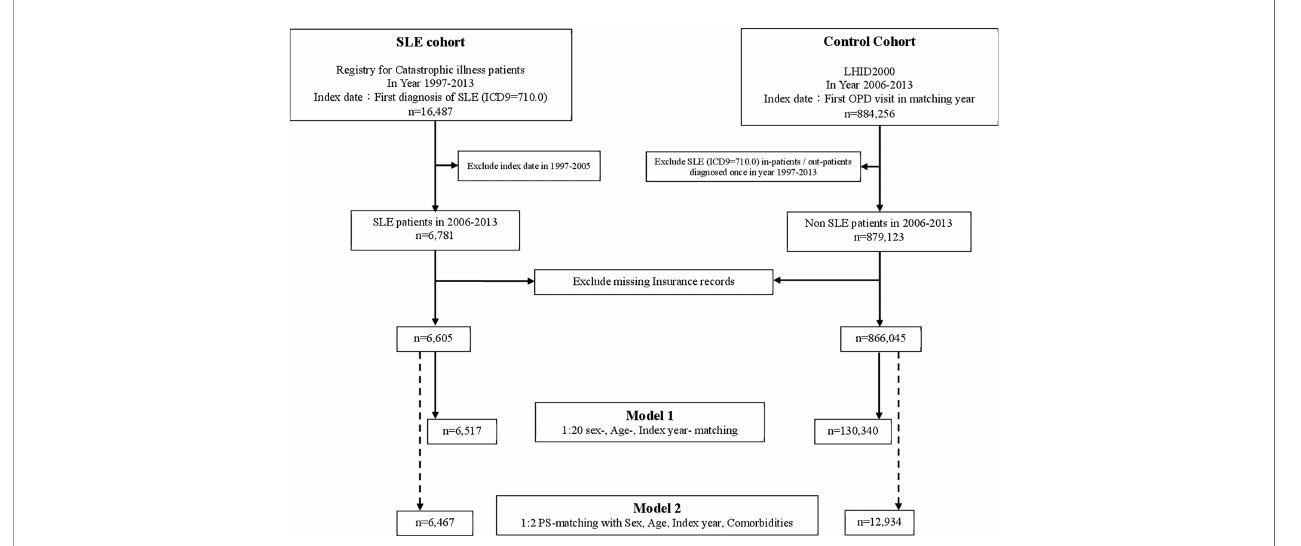
FIGURE 1 | Flowchart. RFCIP, Registry for Catastrophic illness patients; LHID, Longitudinal Health Insurance Research Database; SLE, Systemic lupus erythematosus; OPD, outpatient department; PS-matching, Propensity score